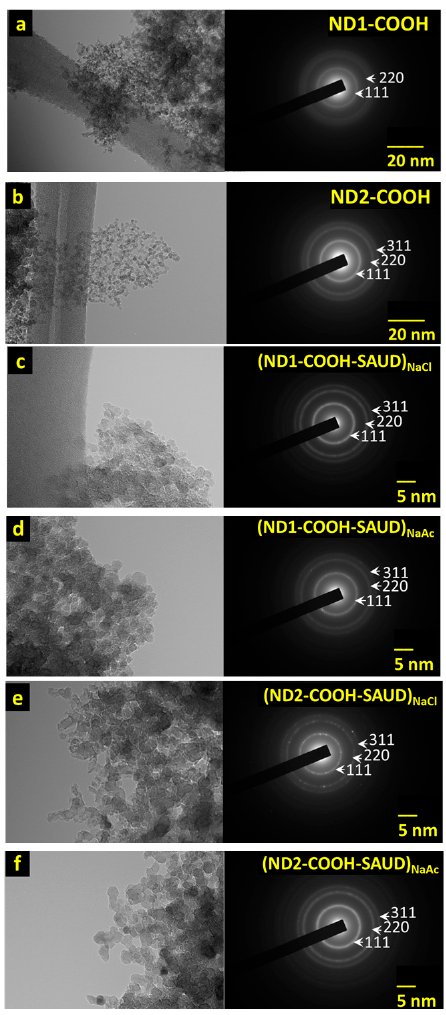
Figure 2. ( a – f ) Transmission electron microscopy (TEM) micrographs of unprocessed and two different salts (sodium chloride; NaCl and sodium acetate; NaAc) processed nanodiamond series (ND1-COOH and ND2-COOH) and corresponding selected area electron diffraction showing characteristic diamond peaks with (hkl) assignment. The scale bar is 20 nm for the micrographs and selected-area electron diffraction (SAED) images are shown at the bottom of the images.